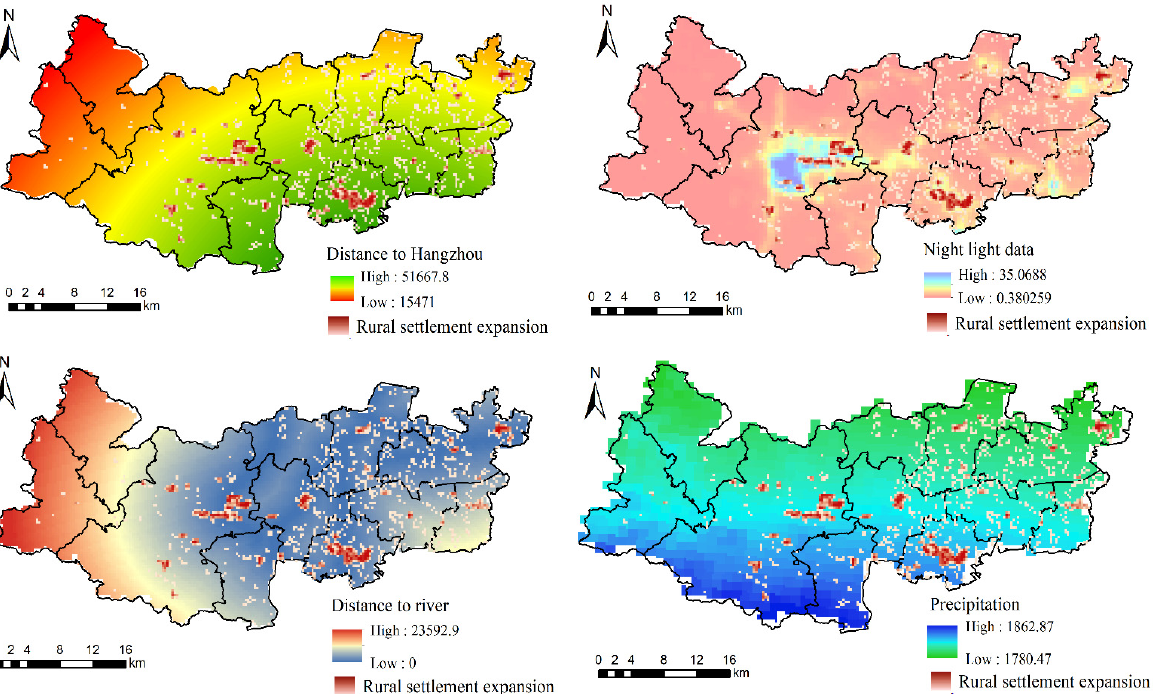
Figure 13. Spatial relationship between the most important factors and the expansion of the corre- sponding rural settlements.